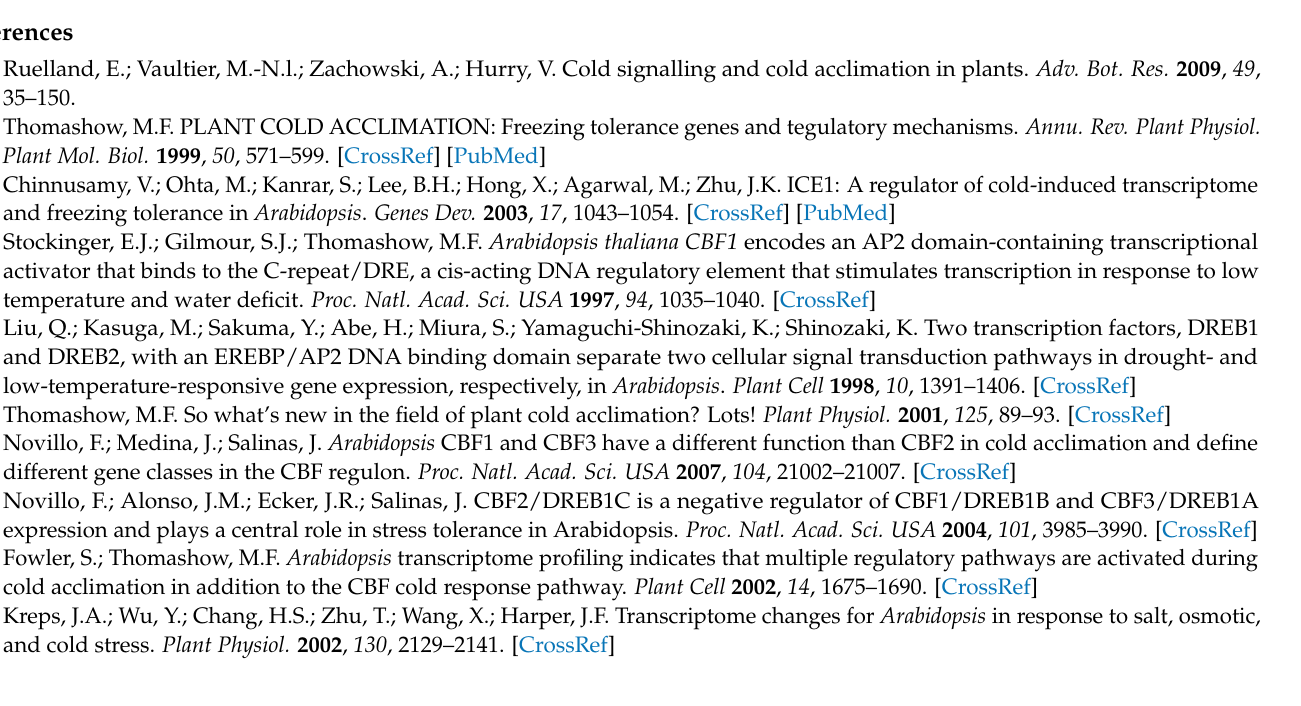
Figure S3: PHY phylogenetic tree in Setaria viridis , Oryza sativa , Zea mays and Arabidopsis thaliana . Figure S4: Venn diagram analysis of DEGs under three different treatments. Figure S5: Eigengene expression profile for the 15